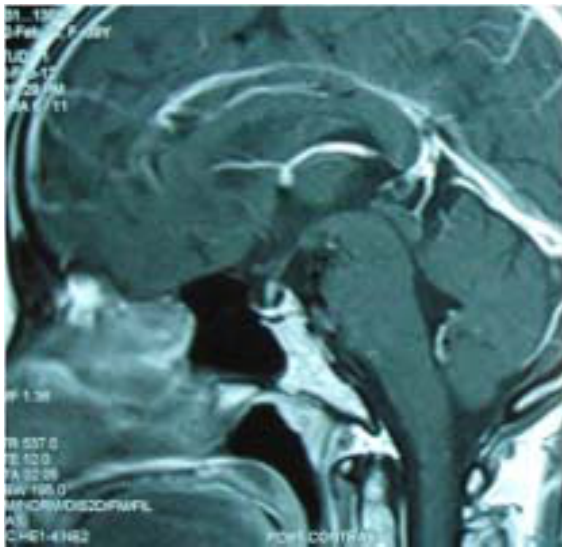
Figure 1. Gadolinium enhanced T1-weighted MR pituitary saggital image show central low signal intensity with a thin rim of enhancing tissue along the sellar floor. CSF is noted in the sella (“empty